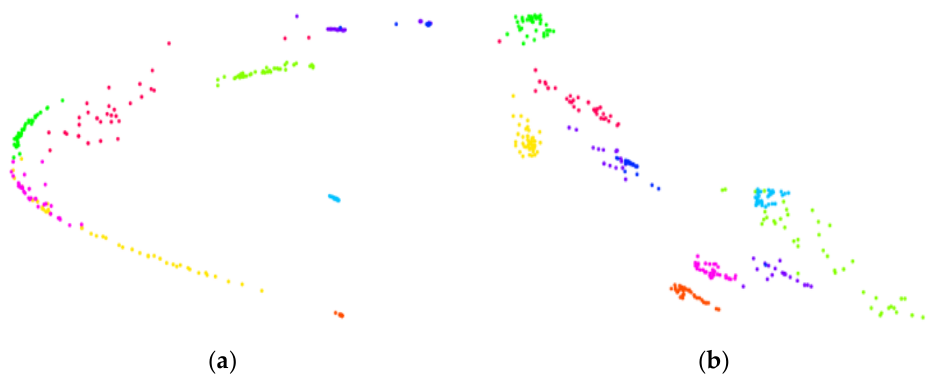
Figure 10. PCA diagram. ( a ) PCA diagram before fine-tuning and ( b ) PCA diagram after fine-tuning.